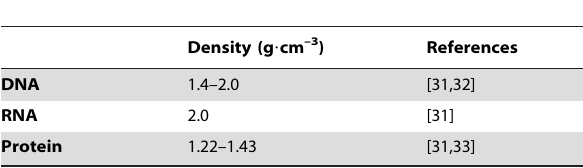
Table 1. Density of chemical components of cells. Table 2. Approximate chemical composition of a bacterium, yeast and mammalian